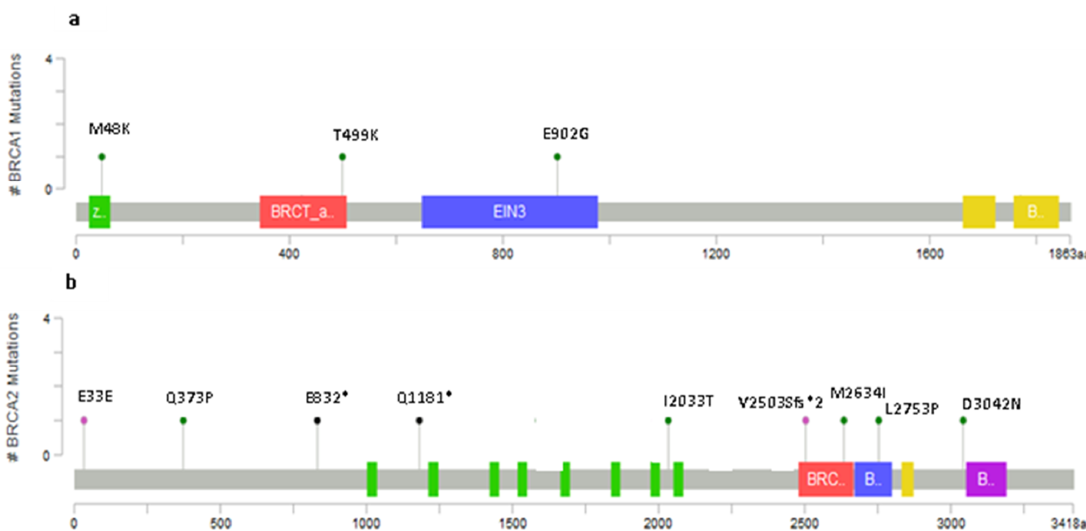
Figure 2. Lollipop plots showing the distribution of novel BRCA1 variants ( a ) and BRCA2 ( b ) identified in our patients’ group. The plots were obtained by the informatic tool Mutation Mapper—cBioPortal for Cancer Genomics (GenBank Reference BRCA1 : NM_007300 and GenBank Reference BRCA2 : NM_000059).